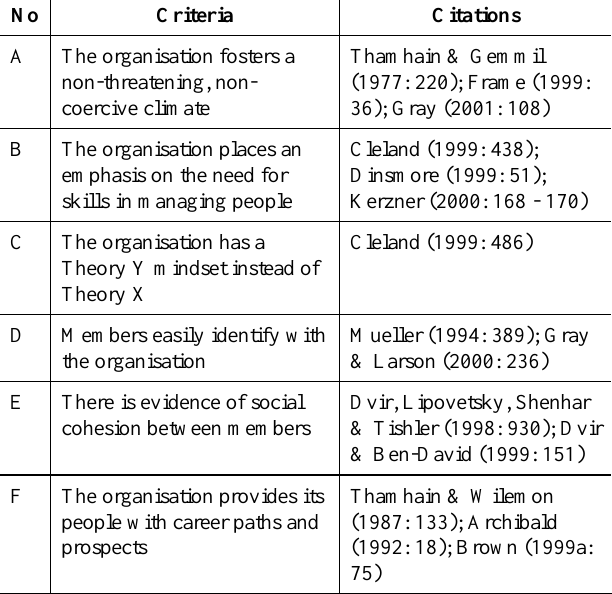
Table 11: The need for a people-oriented organization No Criteria